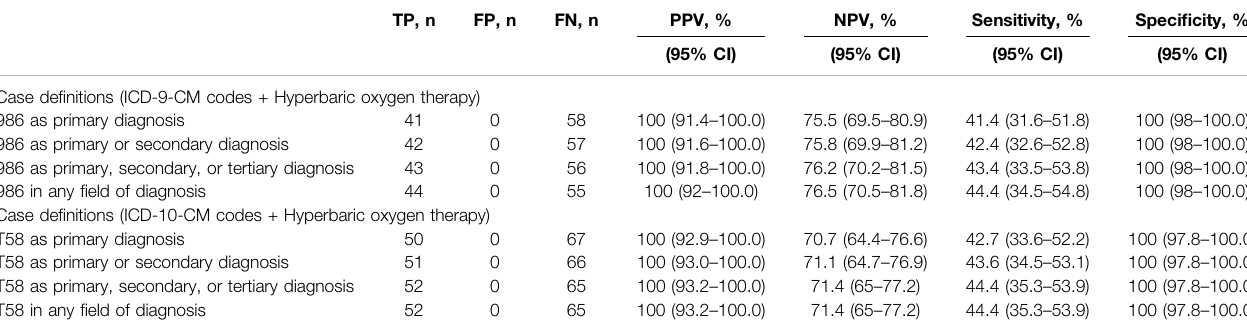
TABLE 4 | Positive predictive value of combined case de fi nitions plus hyperbaric oxygen therapy to identify carbon monoxide poisoning cases.